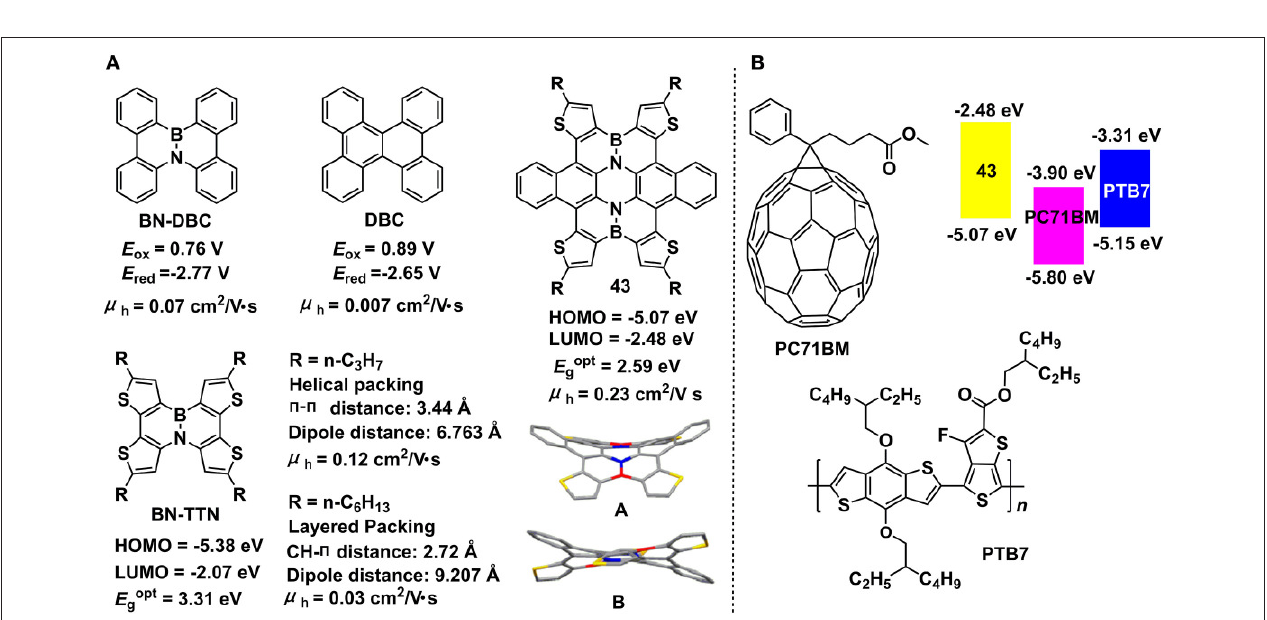
FIGURE 13 | Molecular structures, energy levels, and single crystal parameters for B-N embedded 2D π -conjugated units (A) and photovoltaic applications of compound 43 as an electron donor or additive (B) . Reprinted with permission from Wang et al. (2014). Copyright (2014) American Chemical Society.